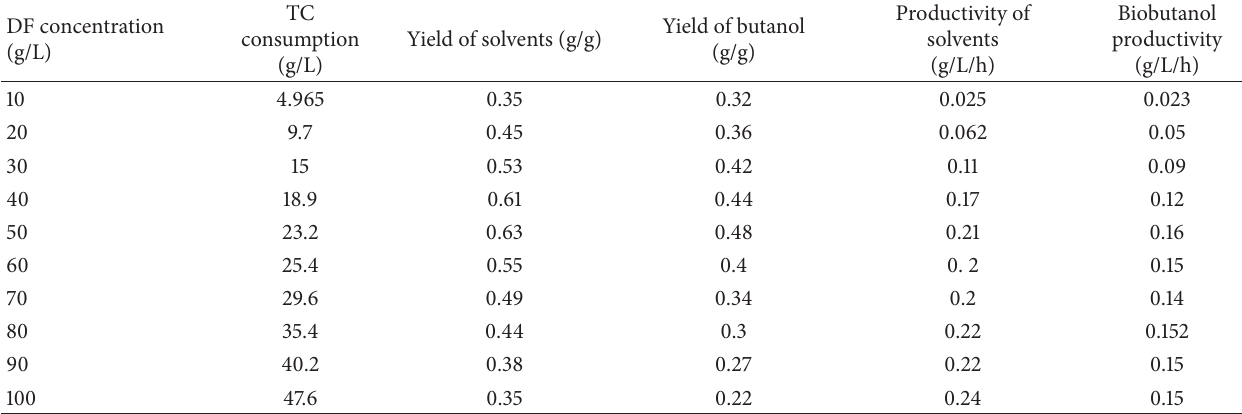
Table 1: Effect of substrate concentrations on yield and productivity of butanol and ABE.